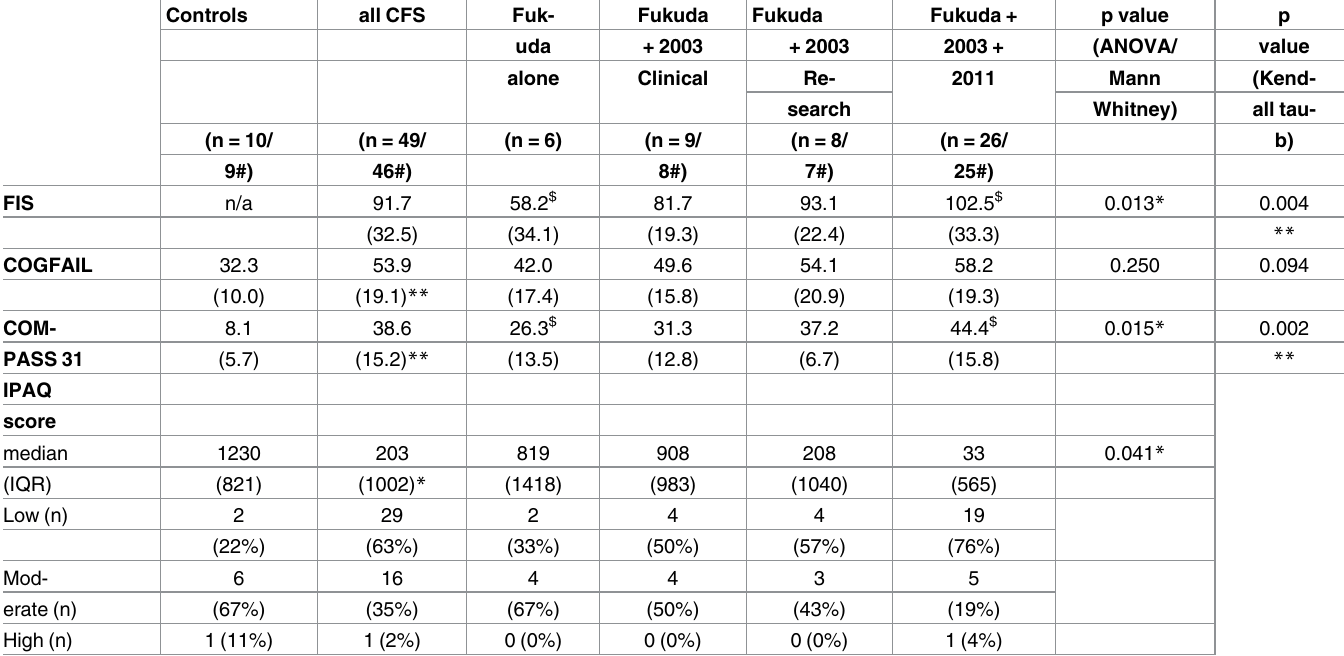
Table 3. IPAQ scoring and outcome measuresby DSQ.